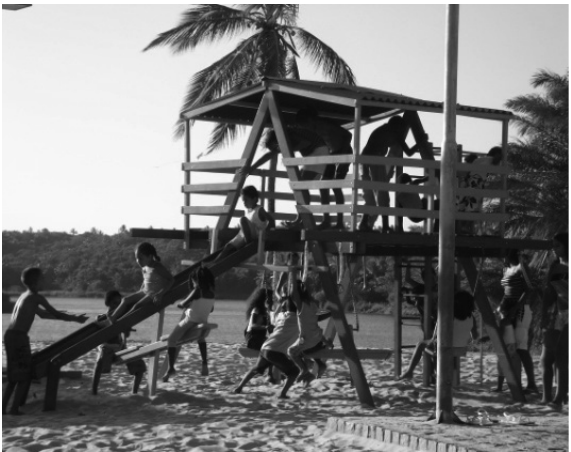
Figura 1 . Exemplo de um lugar planejado e um não